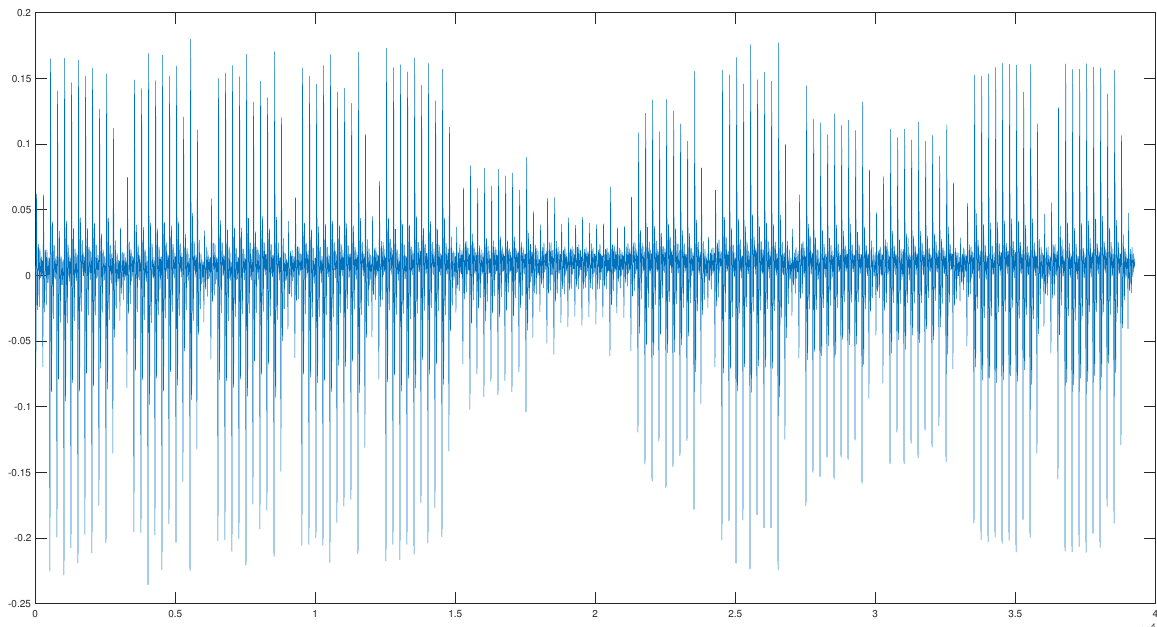
Figure 3. Sample of Protected implementation representing bit